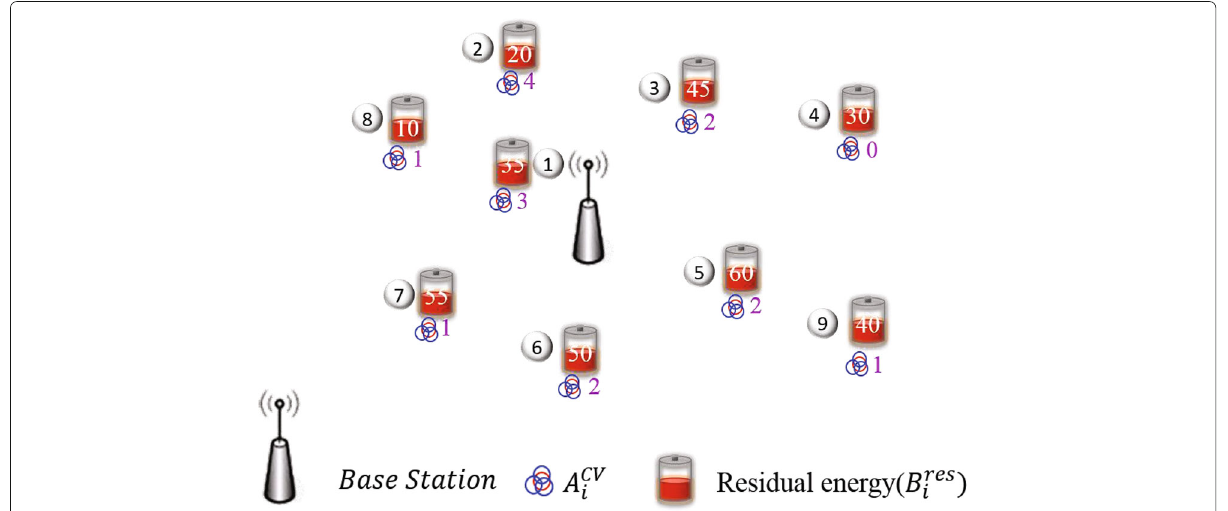
Fig. 6 An example to illustrate the design of the weights of sensors